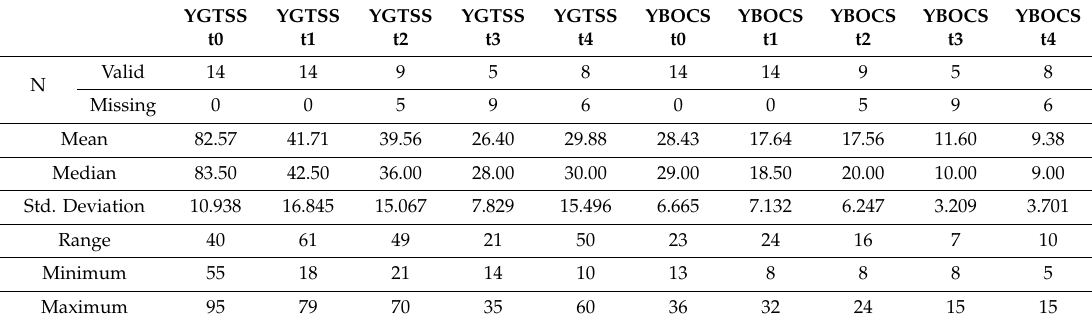
Table 2. YBOCS and YBOCS scores at t0 (baseline) and follow-ups (t1 = 6 months, t2 = 12 months, t3 = 24 months, t4 = 48 months) in the anterior-medial Globus Pallidus internus (GPi) group. YGTSS t0